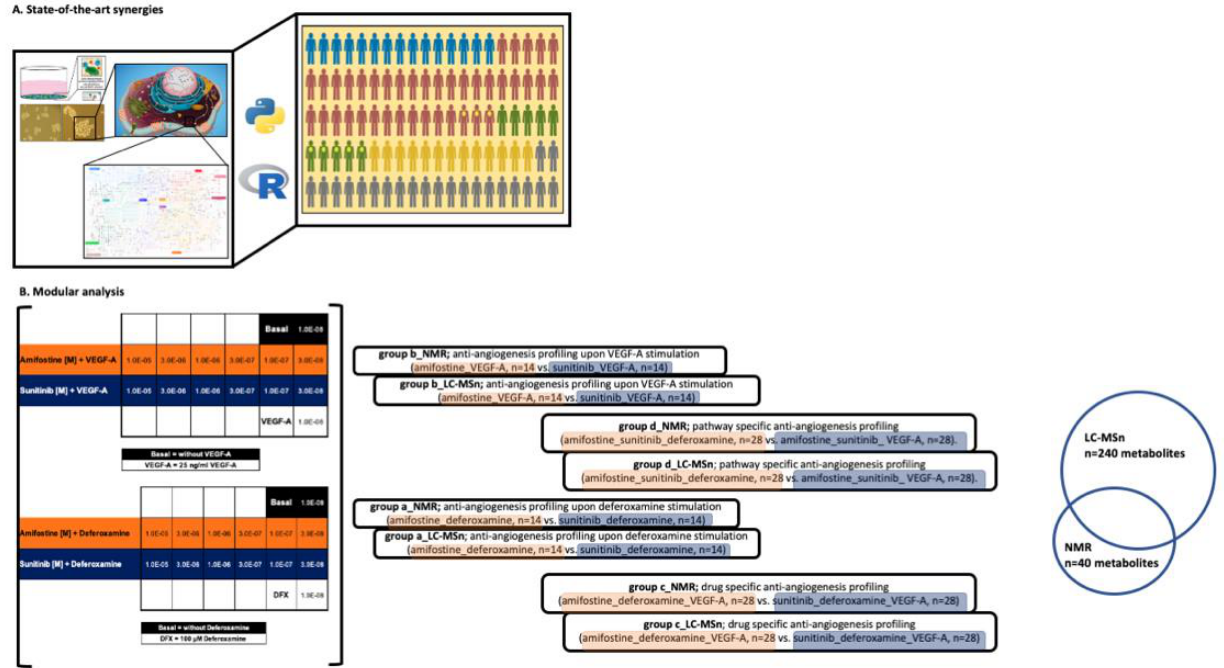
Figure 1. A schematic representation of our strategy. ( A ) State-of-the-art synergies. A 3D cellular angiogenesis assay that mimics human adult angiogenesis in vivo as well as the first stages of the angiogenic cascade was coupled to state-of-the- art technologies (LC-MS and NMR spectroscopy) and chemo-informatics tools/databases to assess the anti-angiogenic action of amifostine in a human adult angiogenesis setting. ( B ) Modular analysis ( n = 3 cell lines, n = 2 cell culture condi- tions, n = 32 test conditions, n = 3 biological replicates (per test condition), and n = 3 technical replicates (per test condition)). Group comparisons are color-coded; orange, angiogenesis stimulation and blue, angiogenesis inhibition. A total of n = 240 metabolites were identified and quantified by LC-MS-based analysis, whereas 40 metabolites were identified and quanti- fied from the 1H CPMG NMR spectra. A total of 36 metabolites were identified and quantified by both LC-MS and NMR spectroscopy.